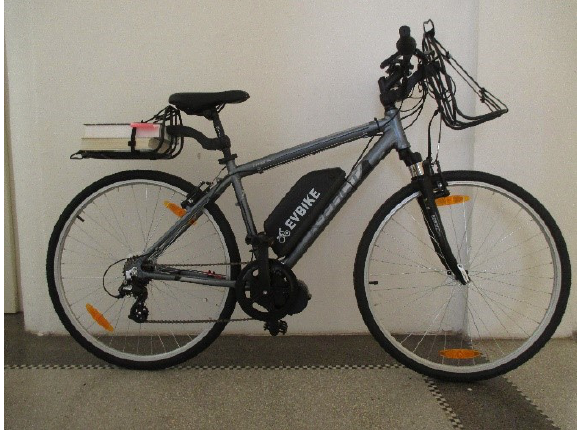
Figure 4. Photo of an assembled